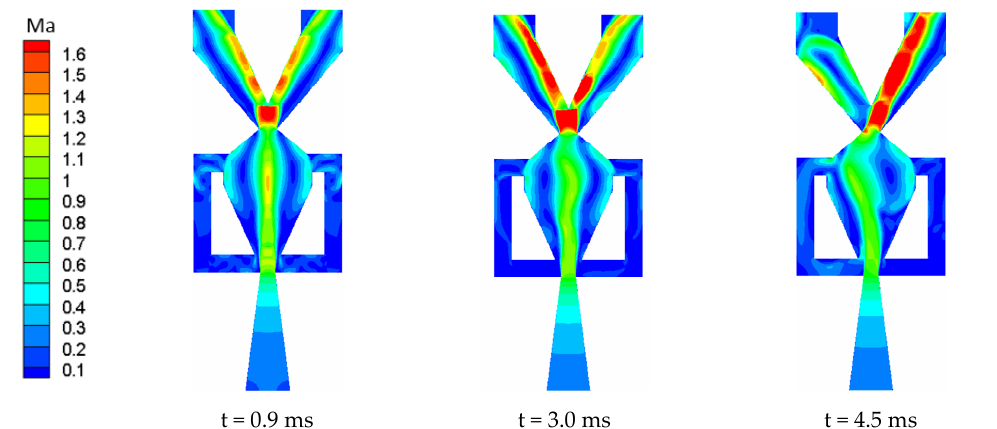
Figure 8. Mach number distribution at different times in model M 5, 6.